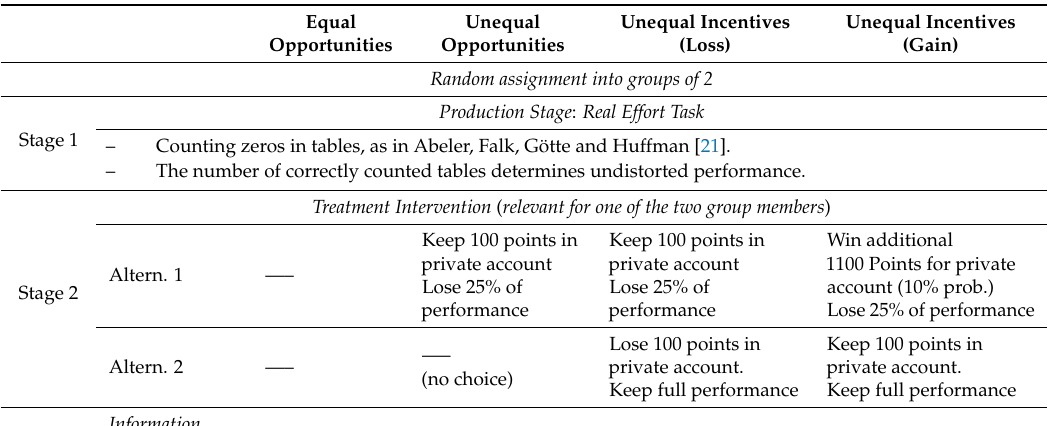
Table 1. The experimental